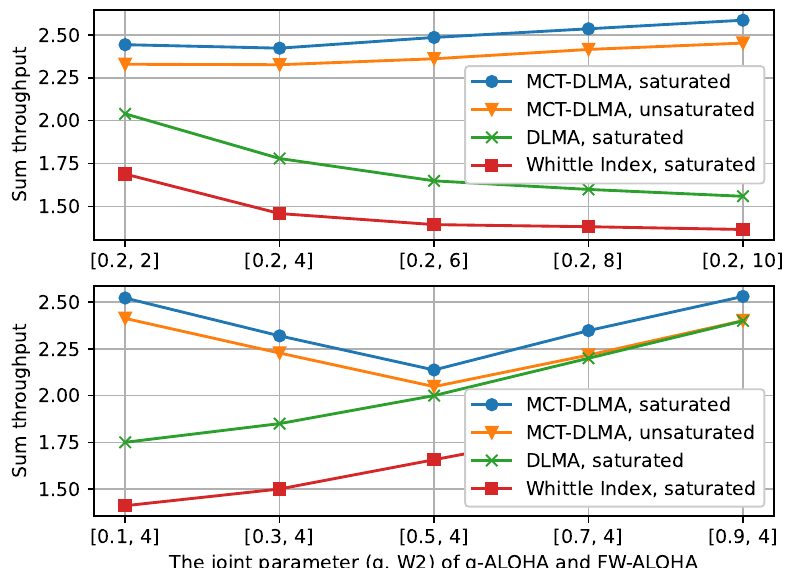
Figure 5. Sum throughput when CU coexists with one TDMA PU, one Q-ALOHA PU, and one FW-ALOHA